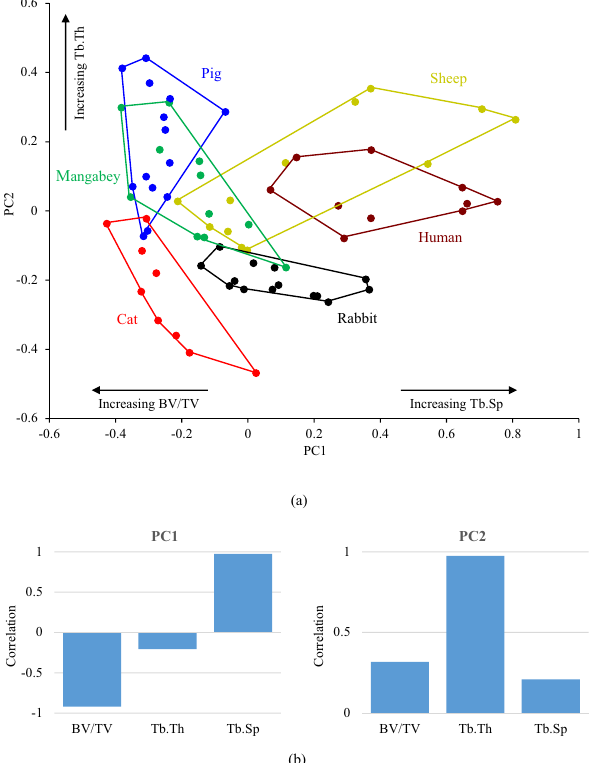
Figure 2. Results of ( a ) the PCA of three trabecular parameters within the RTT bone, and ( b ) the correlation of the three measures to principal components 1 (PC1) and 2 (PC2).